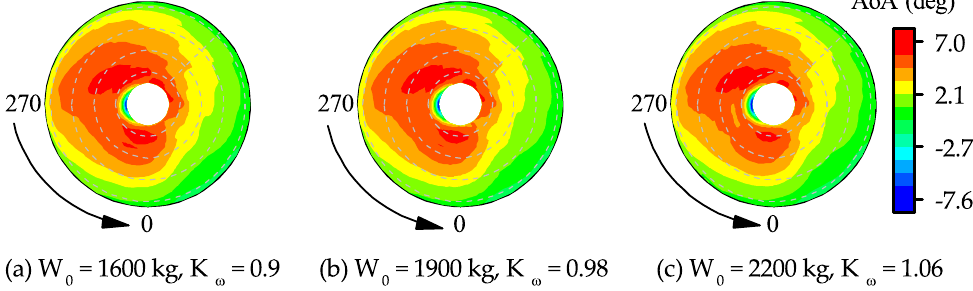
Figure 6. µ = 0.15, AoA (angle of attack) with rotor speed.